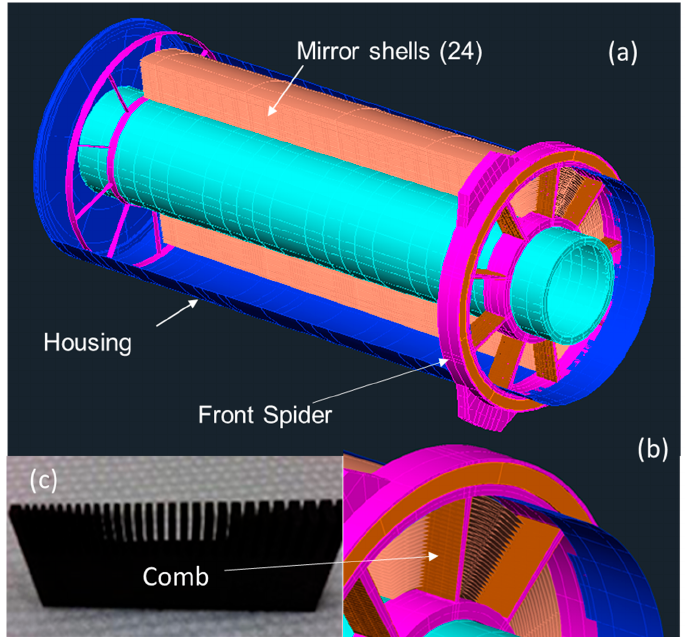
Figure 12. Schematic of a single IXPE mirror module assembly (MMA). ( a ) Entire MMA; ( b ) close-up of the front spider; and ( c ) close-up of an alignment comb.